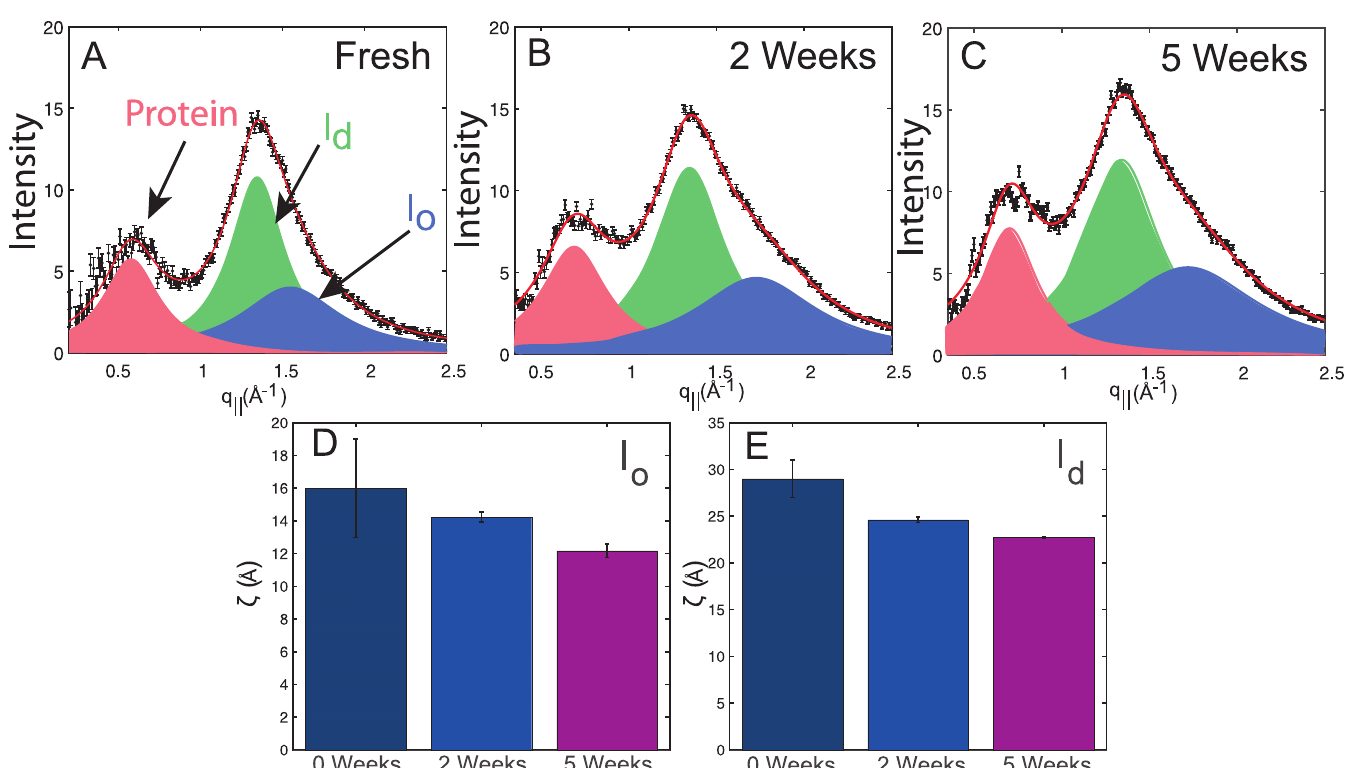
Fig 2. A—C Background corrected in-plane X-ray intensity profiles. Three peaks resulting from liquid ordered l o and liquid disordered l d lipid domains, as well as α - helical protein structures were observed and fits are shown in blue, green and red respectively. The domain sizes were determined as described in Materials & methods and are expressed as the edge length of the domain. They are plotted in D and E